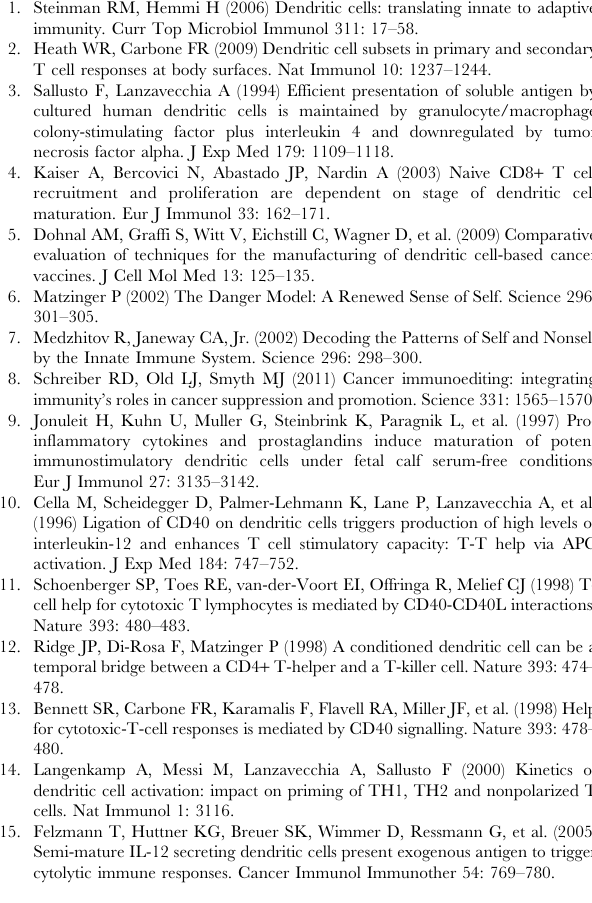
Table S1 Concentration of LPS used for maturation of DC from different